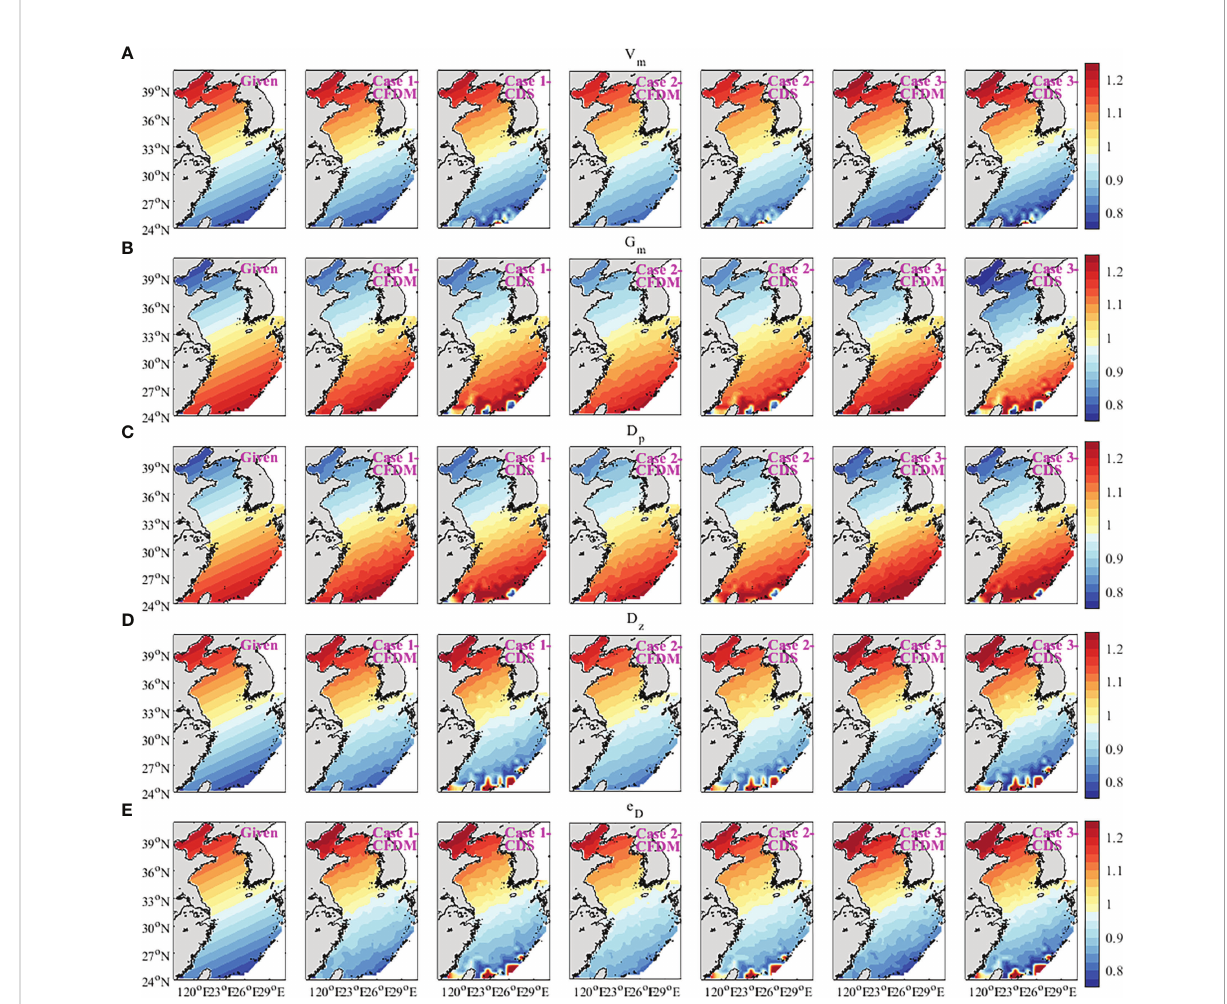
FIGURE 4 Spatial variation of fi ve inversion parameters in the experiment of optimizing parameters simultaneously (unit: day − 1 ). (A) V m , (B) G m , (C) D p , (D) D z , and (E) e D